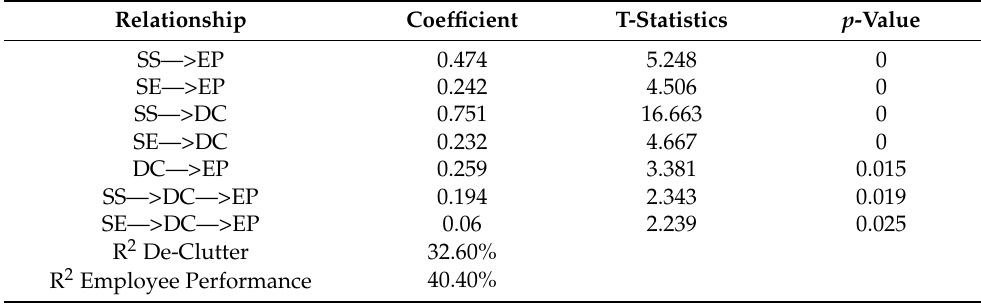
Figure 2. Structural Model. Table 4. Path Coefficients and Significant Values.